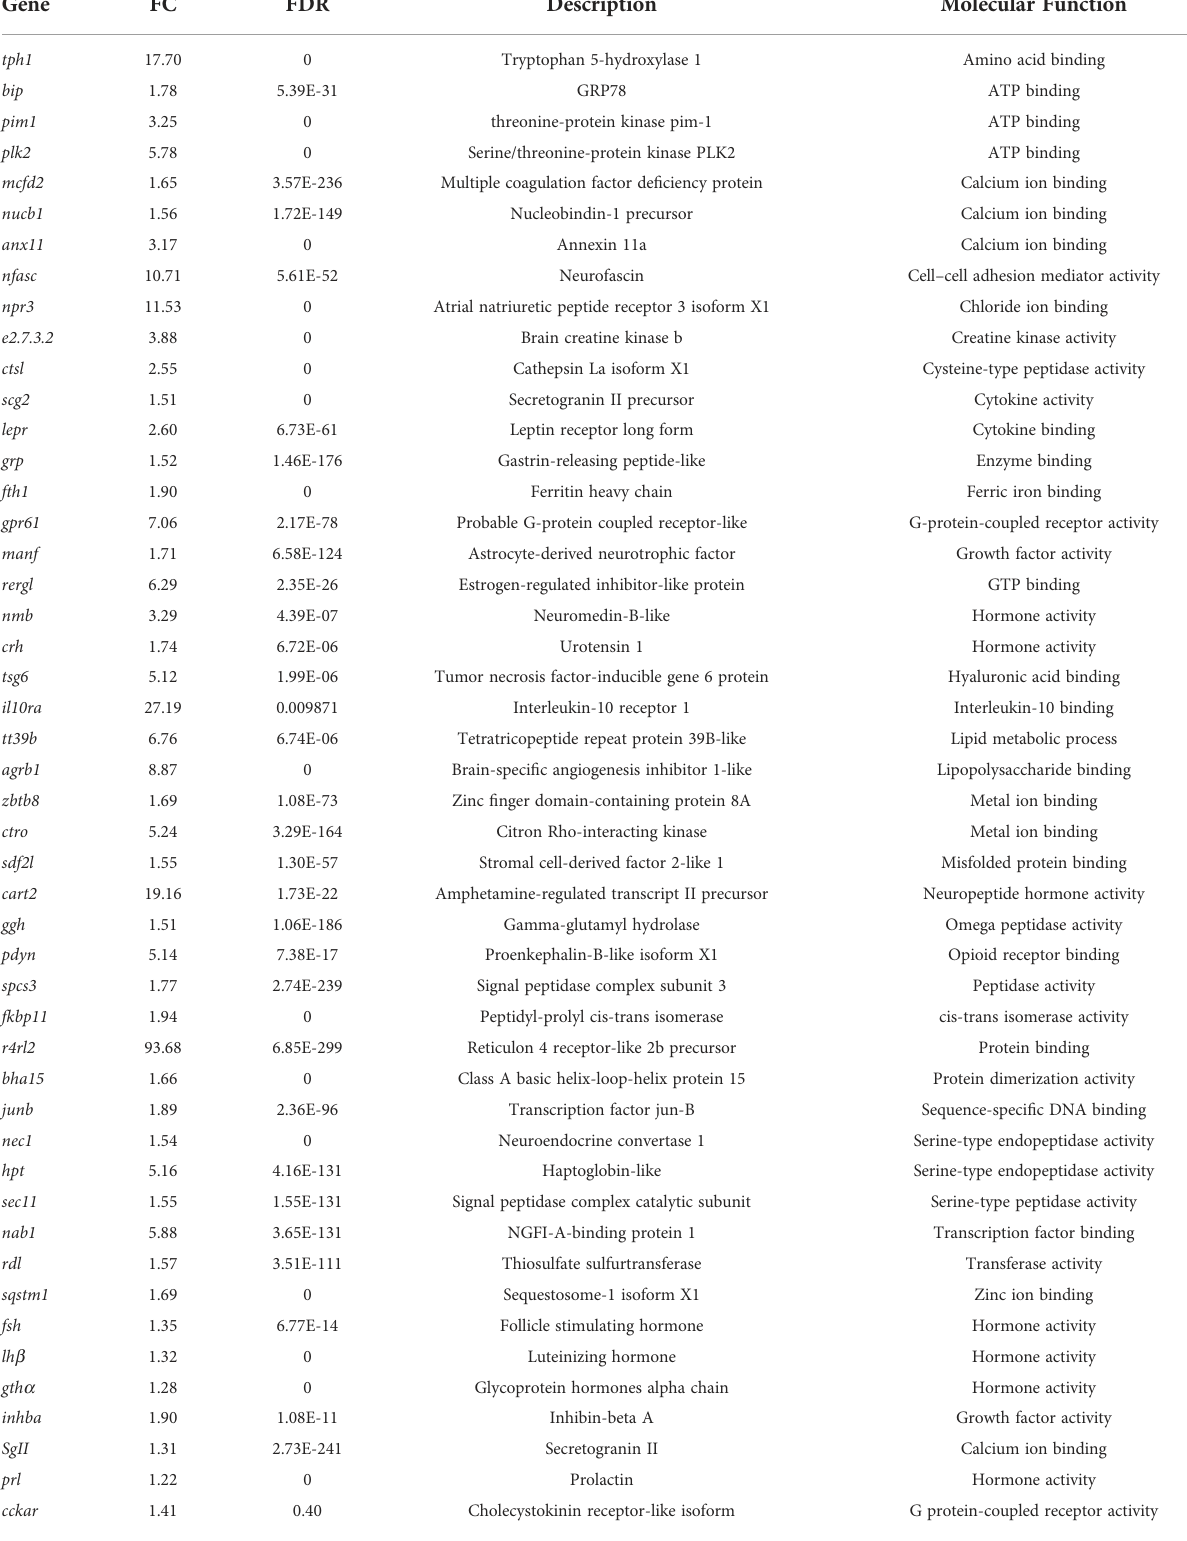
TABLE 1 Upregulated genes by GnRH3 in grass carp pituitary cells. Gene FC